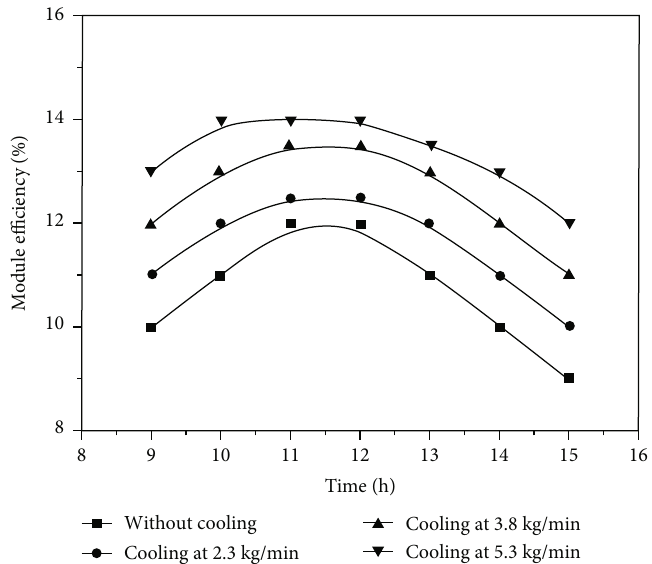
Figure 7: PV module e ffi ciency.